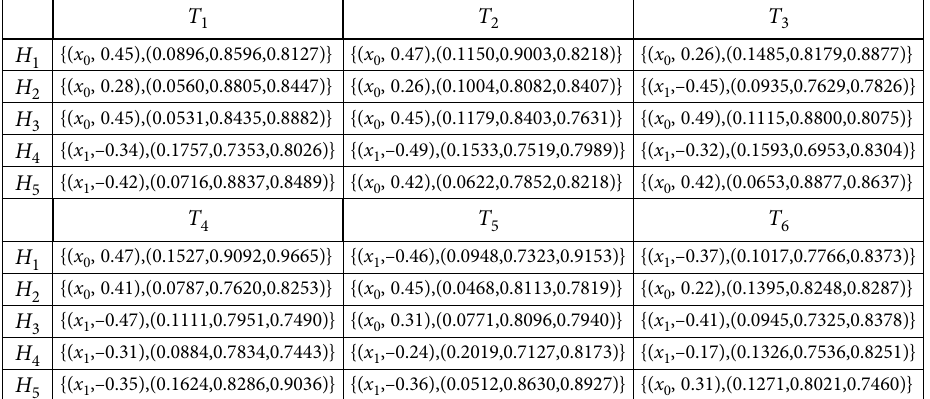
Table 5. The weighted decision-making matrix C T 1 T 2 T 3 H 1 {( x 0 , 0.45),(0.0896,0.8596,0.8127)} {( x 0 , 0.47),(0.1150,0.9003,0.8218)} {( x 0 , 0.26),(0.1485,0.8179,0.8877)}